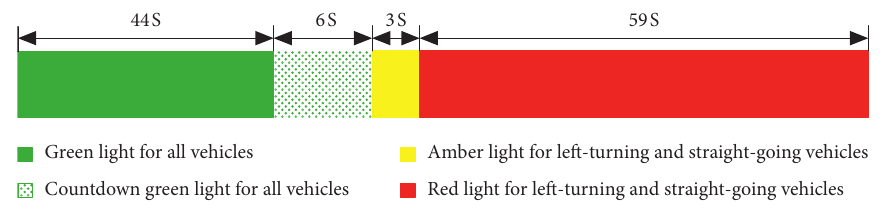
Figure 1: Traffic light phase at H-W